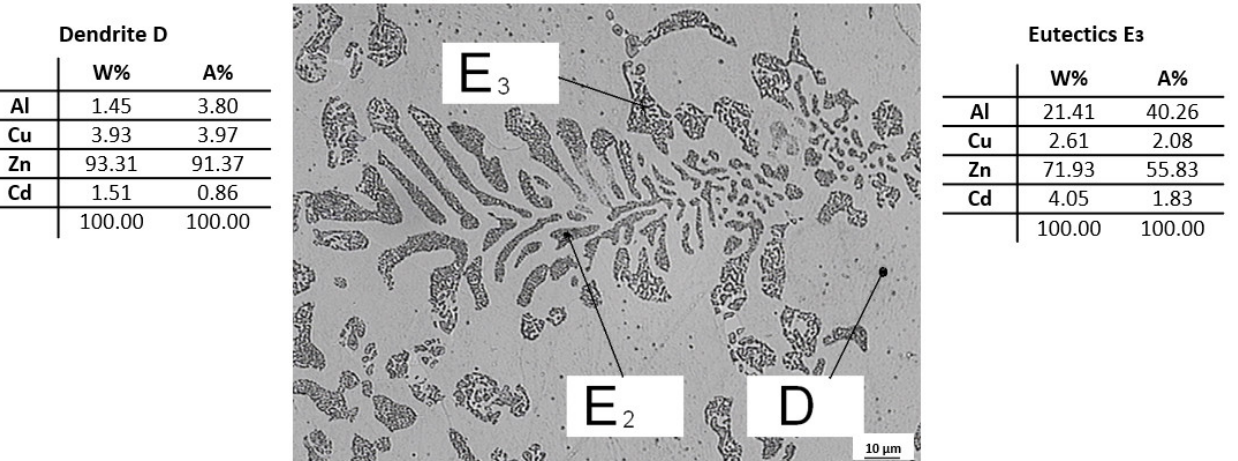
Figure 15. Fractography evaluation of ZnAl4Cu3 alloy: ( a ) after first remelting, P1; ( b ) after third remelting, P3; and ( c ) after ninth remelting, P9.